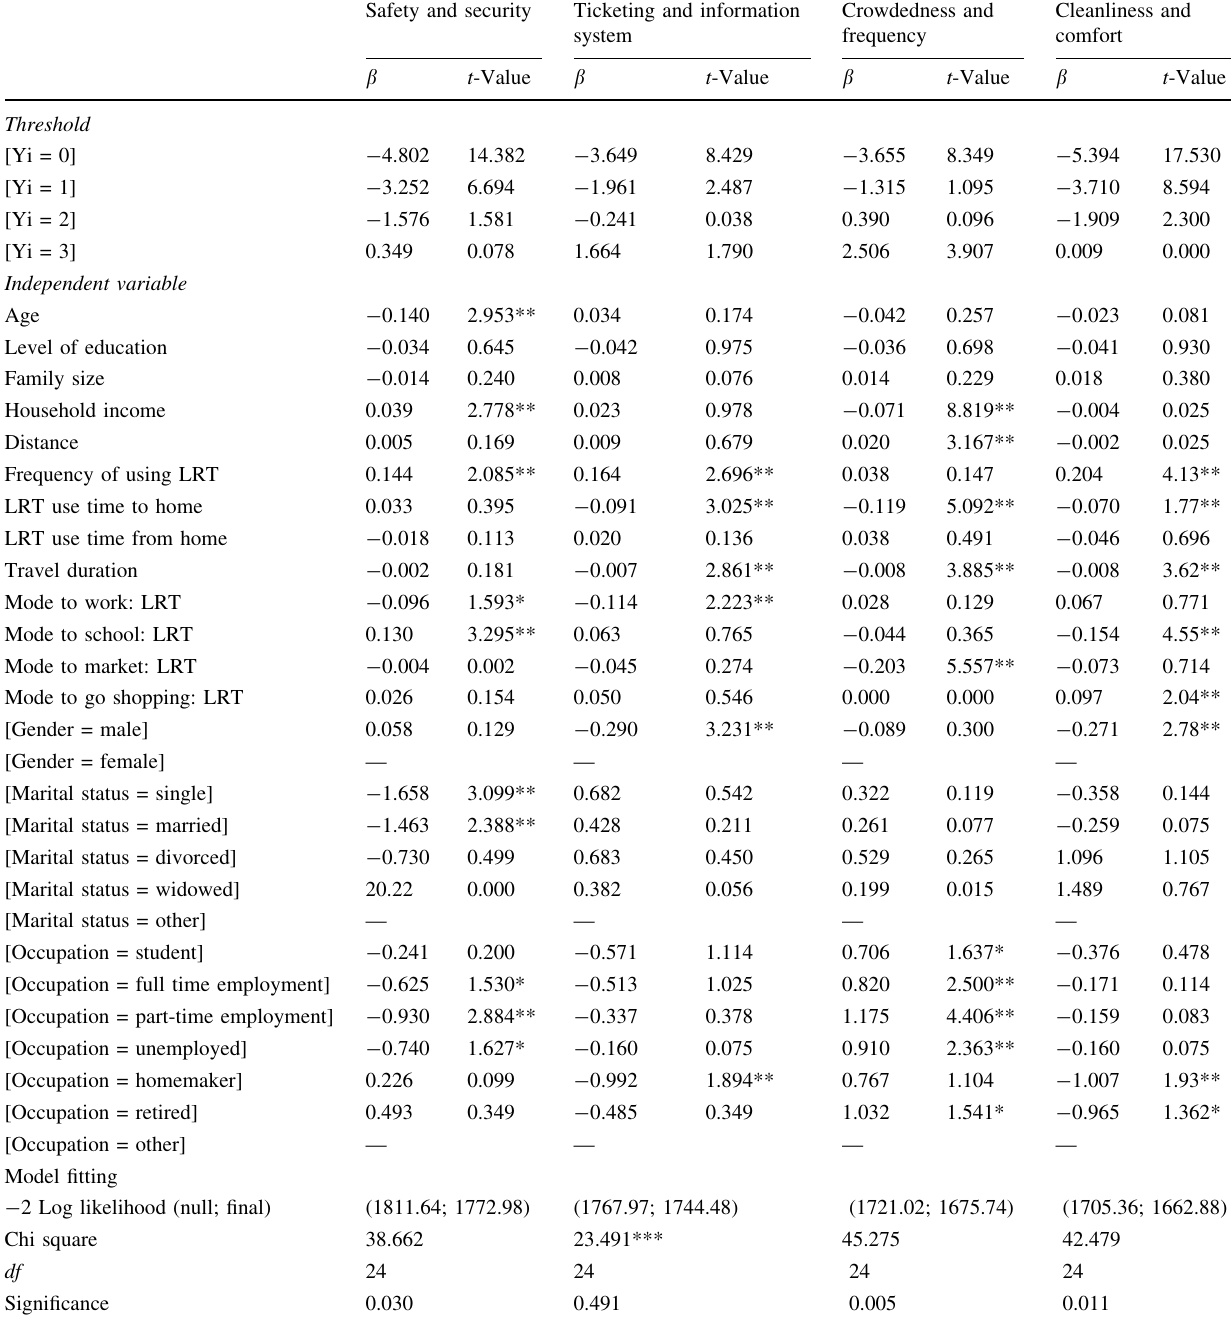
Table 3 Ordered logit model